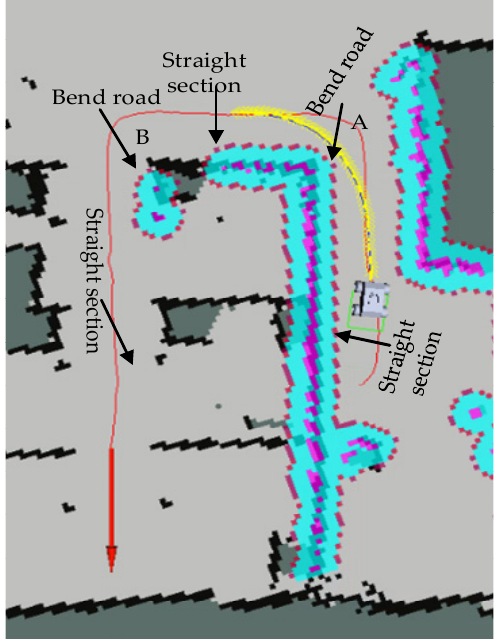
Figure 6. U-shaped path scenario for AGV operation.